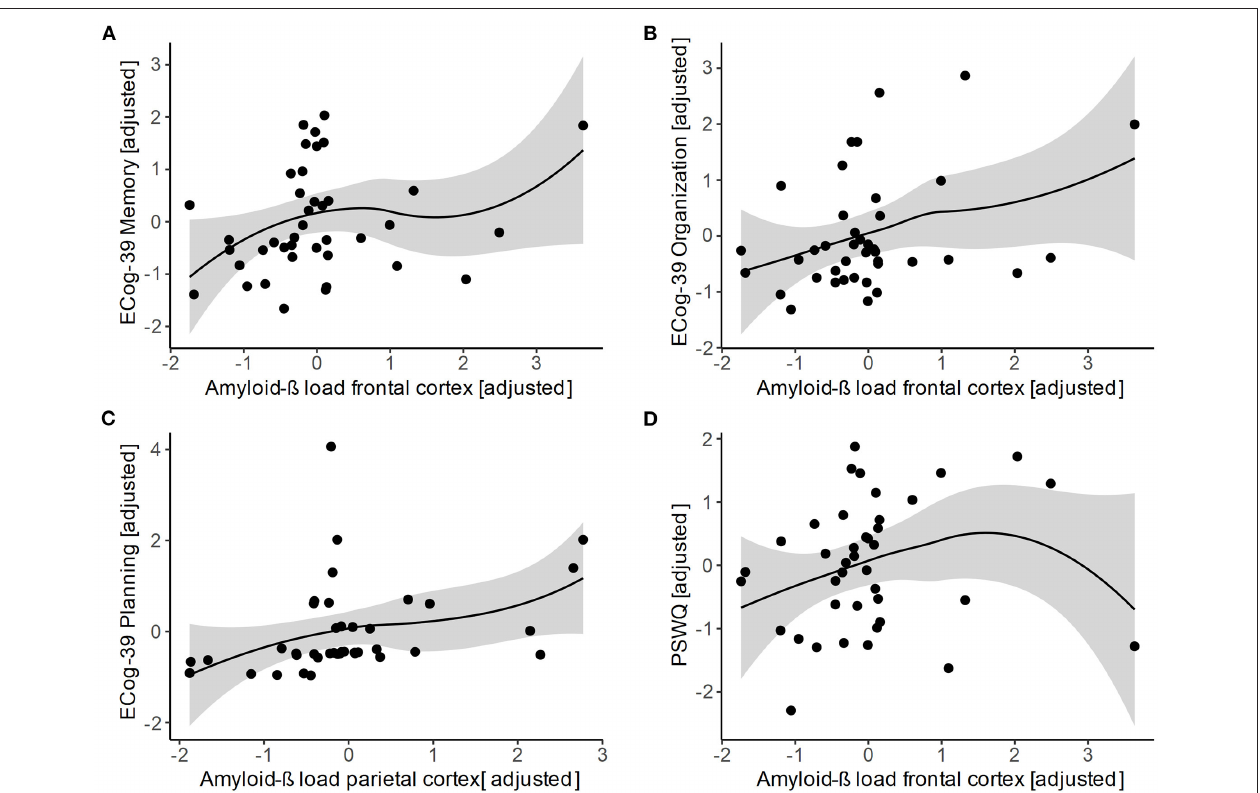
FIGURE 1 | Scatter plots of the associations of regional amyloid- β load in the frontal and parietal cortex with subjective cognitive complaints in (A) memory, (B) organization, (C) planning, as well as with (D) level of worry. All variables are standardized residuals after adjusting for age and APOE ε 4 status. Regional amyloid- β load was not corrected for partial volume effects. Loess regression lines with 95% CIs were added. Amyloid- β , amyloid-beta; APOE ε 4, apolipoprotein E ε 4; ECog-39, 39-item Everyday Cognition Scales; PSWQ, Penn State Worry